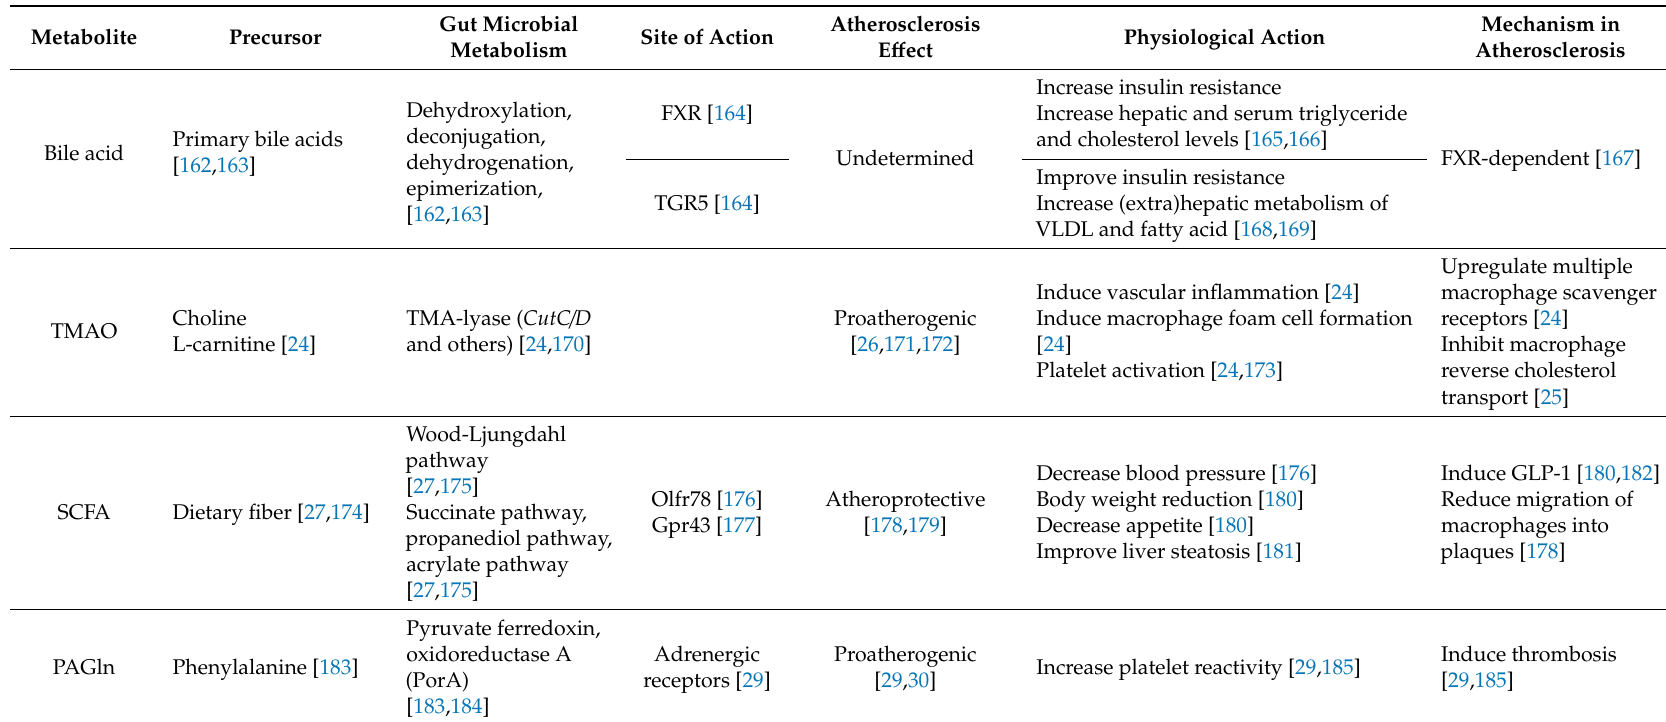
Table 1. Action of microbial metabolites on